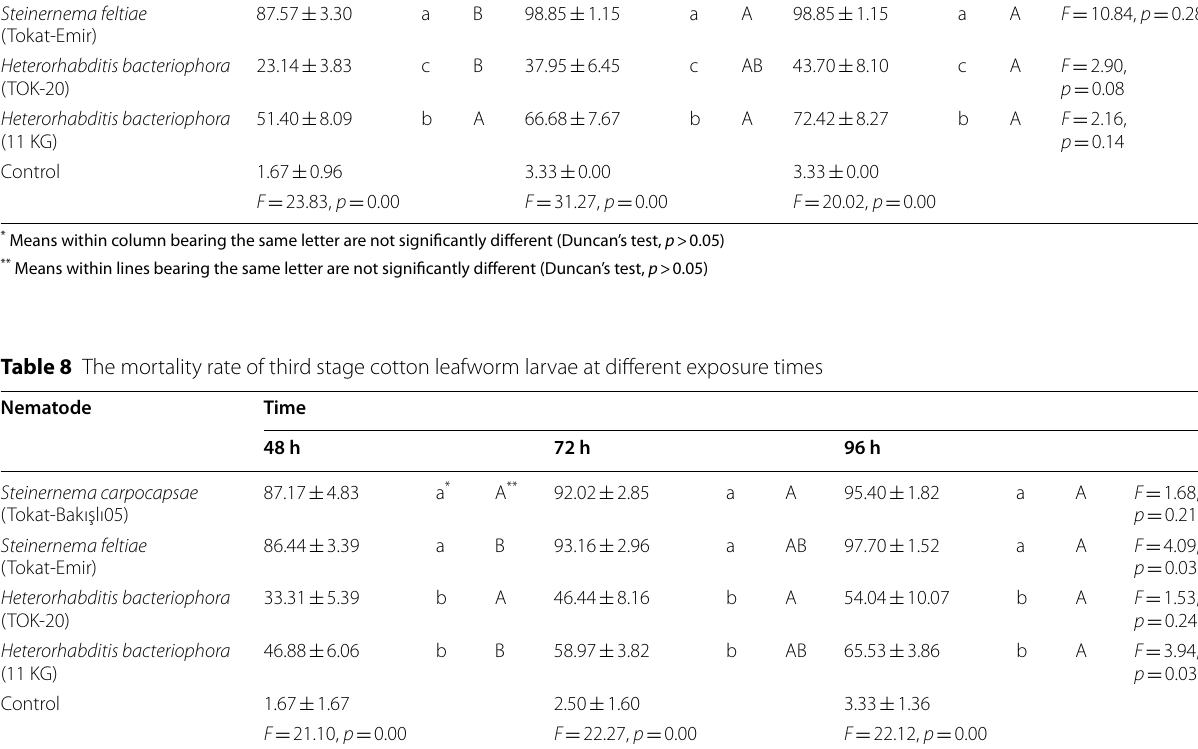
* Means within column bearing the same letter are not significantly different (Duncan’s test, p > 0.05) ** Means within lines bearing the same letter are not significantly different (Duncan’s test, p > 0.05)